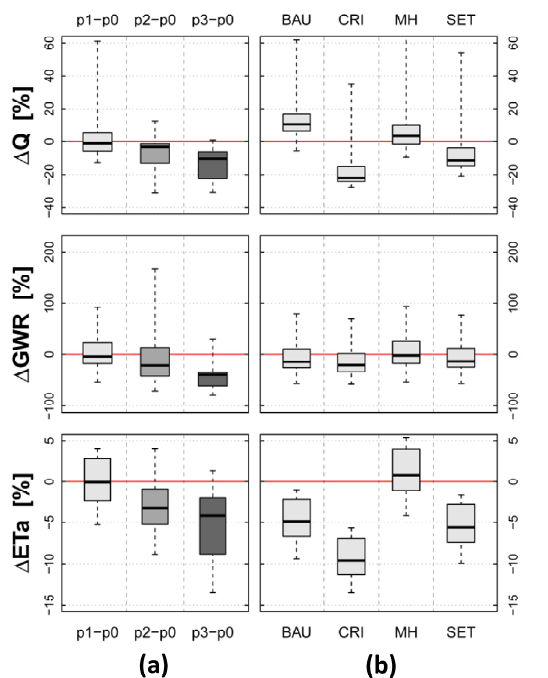
Figure 8. Long-term average annual changes in total inflow (Q) to the lagoon as well as in groundwater recharge (GWR) and actual evapotranspiration (ETa) in the Mar Menor catchment shown as boxplots. ( a ) Climate change impacts, showing results for the three future scenario periods (p1, p2 and p3) compared to the reference period (p0); ( b ) Combined, climate